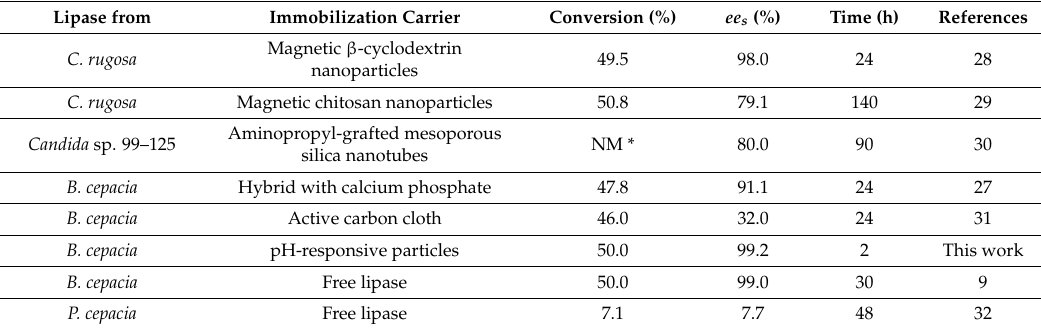
Table 1. Comparison of the enantioselectivity of other